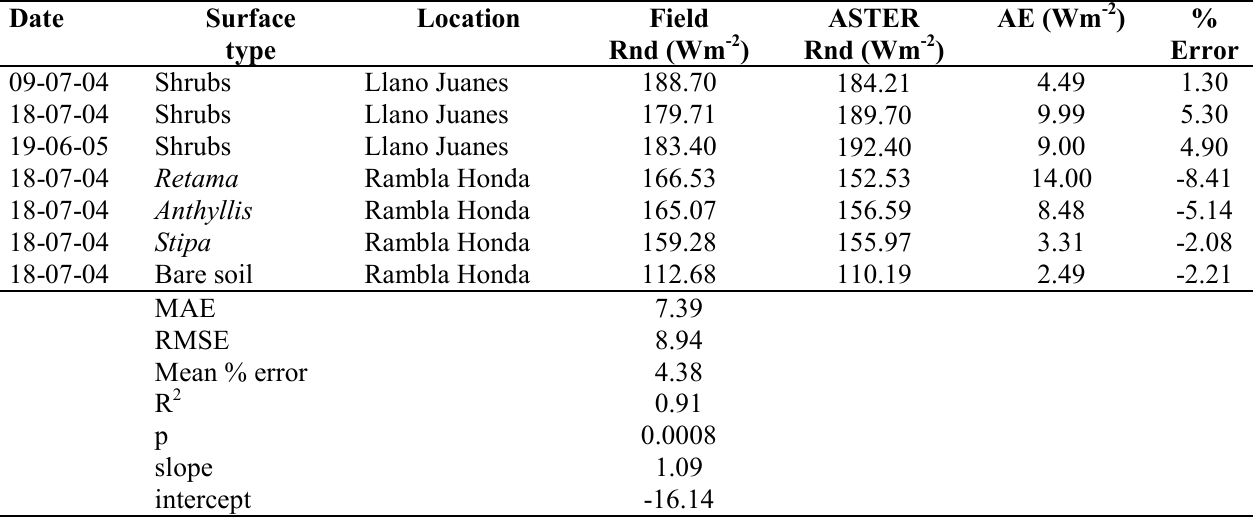
Table 3. Daily Net Radiation Rnd (Wm -2 ) of Retama, Anthyllis, Stipa , shrubs, and bare soil at the Llano de los Juanes and Rambla Honda research sites. “Field” is the Rnd field measurement, and ASTER is the Rnd estimated using ASTER and ancillary data. AE is the absolute value of (Rnd -Rnd ). The % Error is calculated as (Rnd -Rnd )100/ Rnd For an overall error field Aster field Aster field. evaluation, the MAE (mean absolute error), the average AE, the mean % error, (% Error), R 2 (Pearson correlation coefficient), p (probability), slope and regression intercept between field and ASTER results were